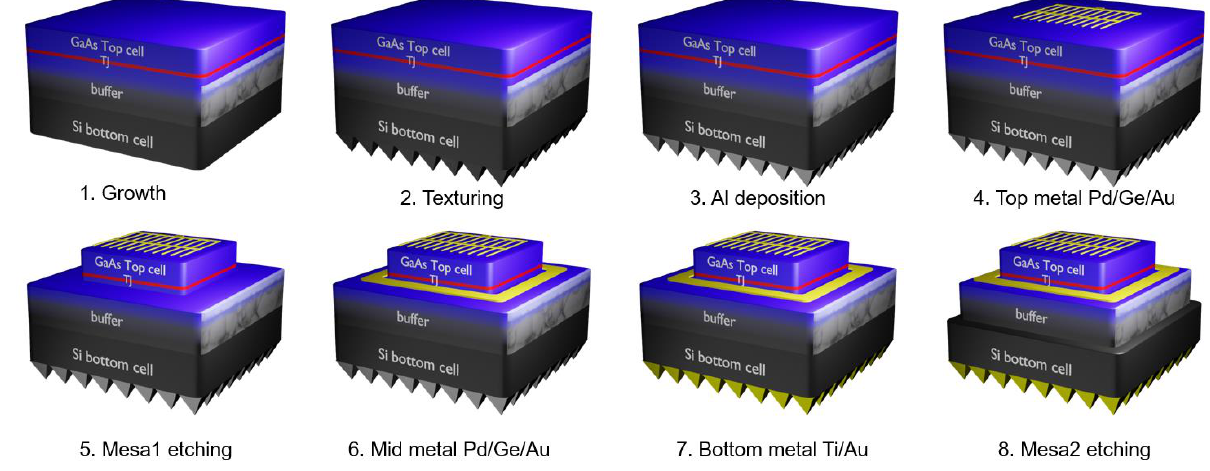
Figure 5. Fabrication procedure of the GaAs/Si tandem solar cell.